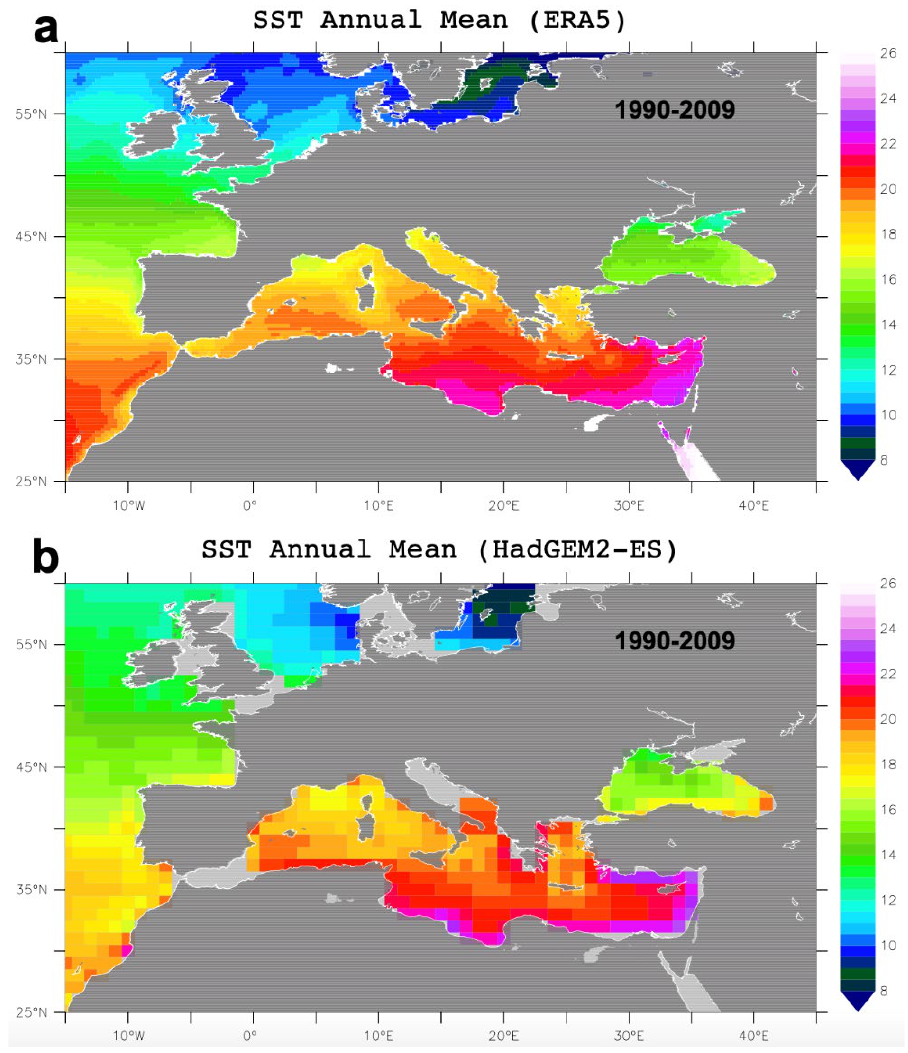
Figure 8. Annual average sea surface temperature for ( a ) ERA5 and ( b ) RegCM input for 1990–2009 . Using the same approach as SevER with increasing the shear threshold to 20 m / s, we obtain “SupER” cases. For a given location, supercells are rare storms, and this shows up in the current climate results (Figure 9a). Most of the cases are fit between 30 and 40 degrees latitude, as these are midlatitude phenomena. The annual average number of SupER is usually 1 or 2 within this belt, which is quite realistic. The Central Mediterranean and coasts facing south or west have more frequent SupER cases. One other hot region is the Caucasus, which actually includes parts of Europe with the highest number of days with lightning strikes [41] and relatively high number of tornadoes despite elevated terrain and underreporting issues based on lower population density